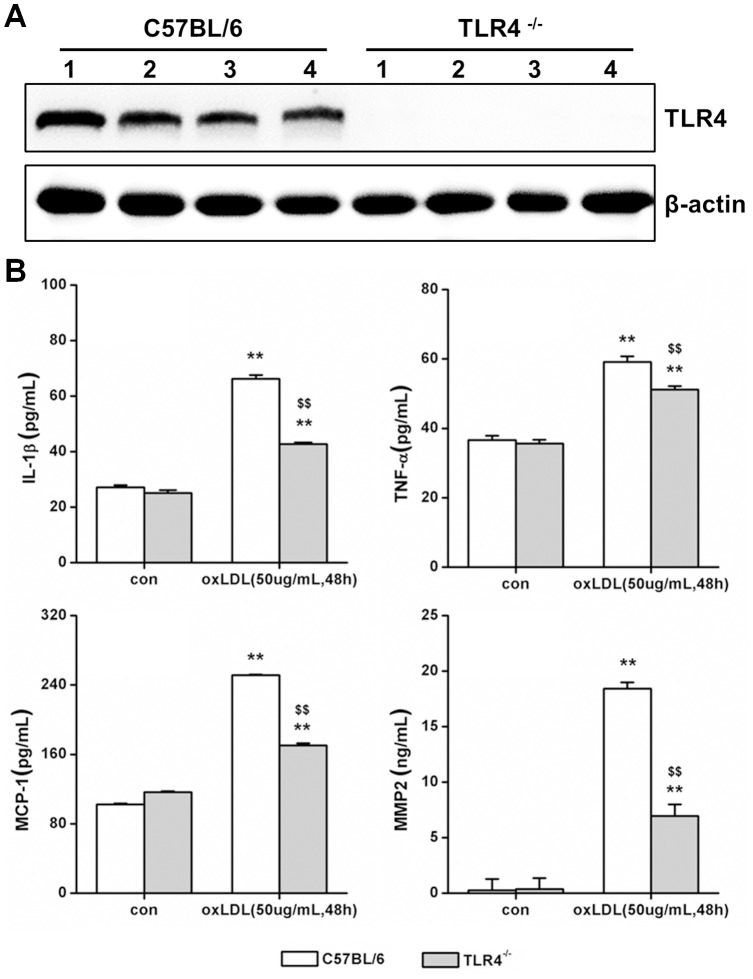
TLR4 knockout weakens IL-1β, TNF-α, MCP-1 and MMP-2 release in primary SMCs.The primary smooth muscle cells have been cultured from TLR4−/− and C57BL/6 mice. (A) The phenotype of TLR4−/− and C57BL/6 had been detected with Western-blot to assay TLR4 expression. Each type mice choose four different mice. (B) The cells have been incubated with or without oxLDL (50 ug/mL) for 48 hrs, and detected the level of IL-1β, TNF-α, MCP-1 and MMP-2 in the supernatant of cell culture medium. (Mean ± SD, n = 3;**P<0.01 compared with con group, $$P<0.01 compared with C57BL/6 mice group).